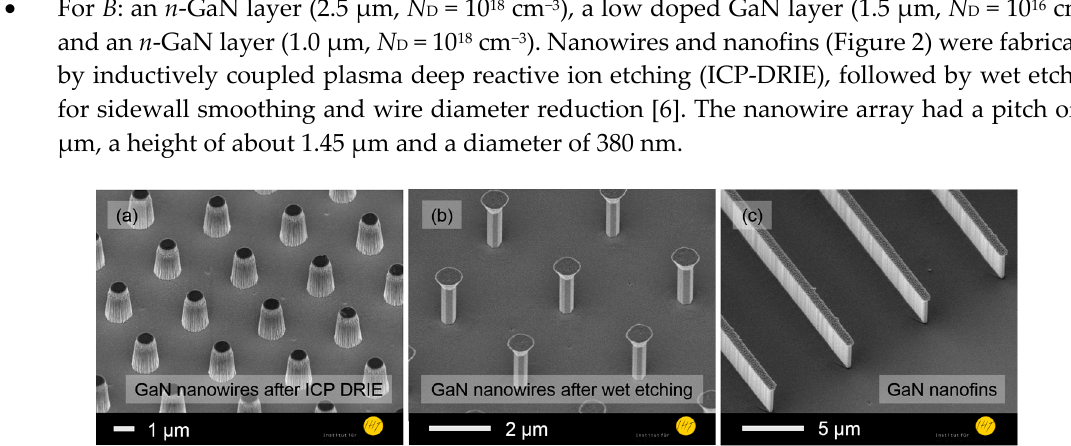
Figure 2. Vertical 3D GaN nanoarchitectures in shapes of nanowires after ( a ) inductively coupled plasma deep reactive ion etching (ICP-DRIE) and ( b ) KOH-based wet chemical etching and ( c )